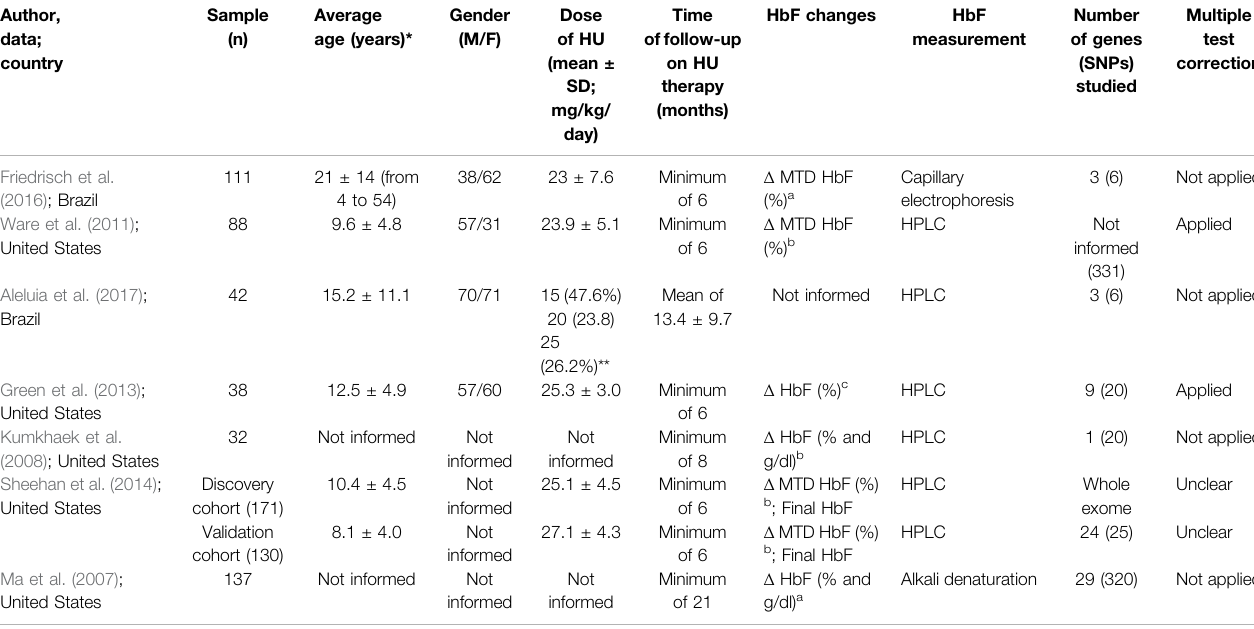
TABLE 1 | Characteristics of the seven cohort studies included in the systematic review, which examined the effects of genetic polymorphisms on fetal hemoglobin (HbF) levels in patients with SCA treated with hydroxyurea